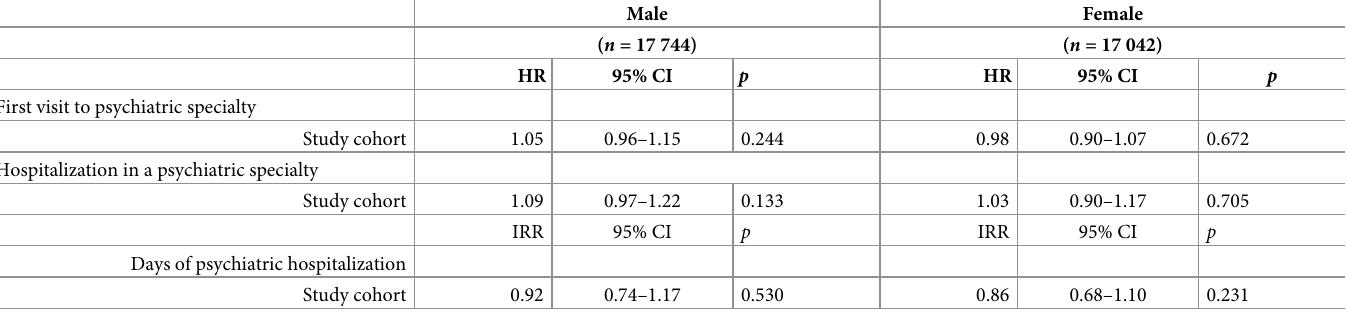
Table 4. Results of comparison between study and comparison cohorts analysed with Cox Proportional Hazard model (HR) and Zero-Truncated Negative Binomial regression (IRR) with 95% CI. by sex. The comparison cohort is the reference group in all models.